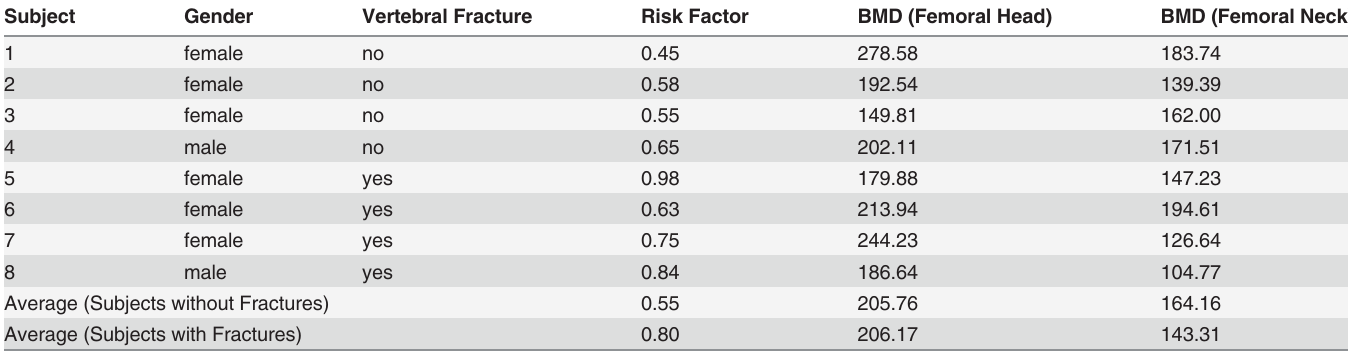
Table 3. Risk factor values calculated for each subject based on FEA simulations presented along with according in-vivo BMD (in mg/cm 3 ) measurements of the femoral head and